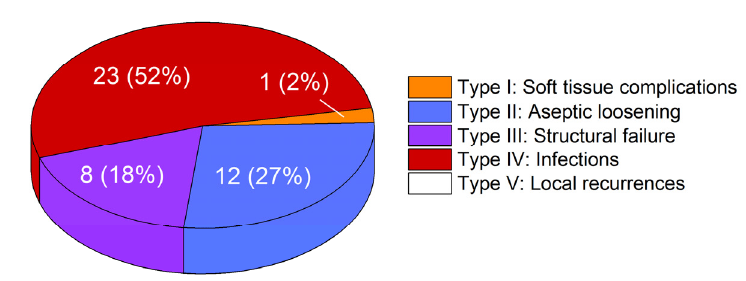
Figure 4. Distribution of failure modes according to the Henderson classification in our collective of 44 retrievals.